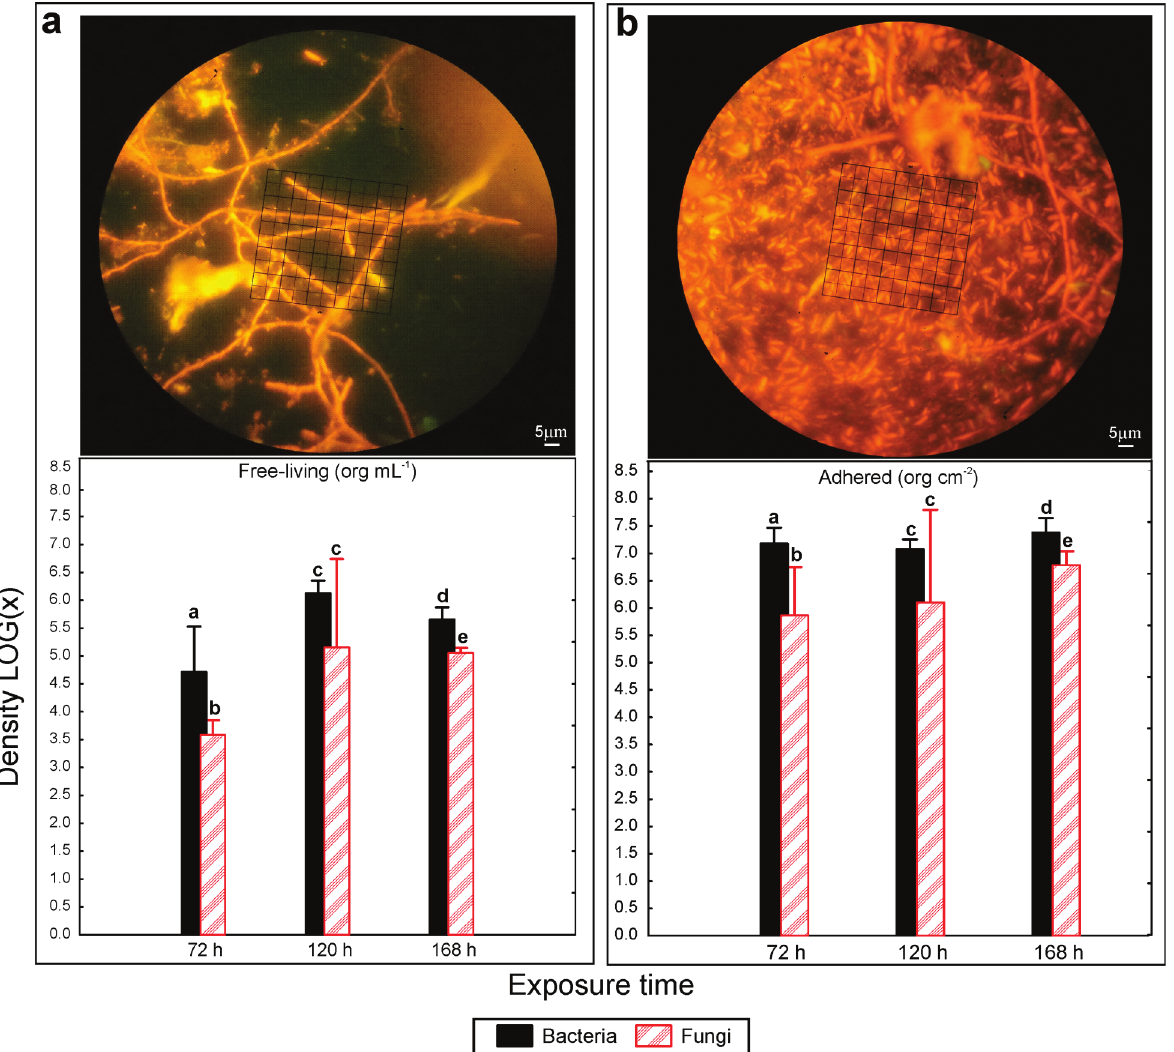
Figure 5 - Two-way ANOVA indicating density of free-living (org mL -1 ) (a) and adhered (org cm -2 ) microorganisms (b). Top figures are pictures, while bar graphs compare the density of bacteria and fungi after 72, 120 and 168 hours of exposure to T2. The bars represent the confidence intervals (95 %) and lowercase letters indicate similarities or statistical differences between treatments for each time